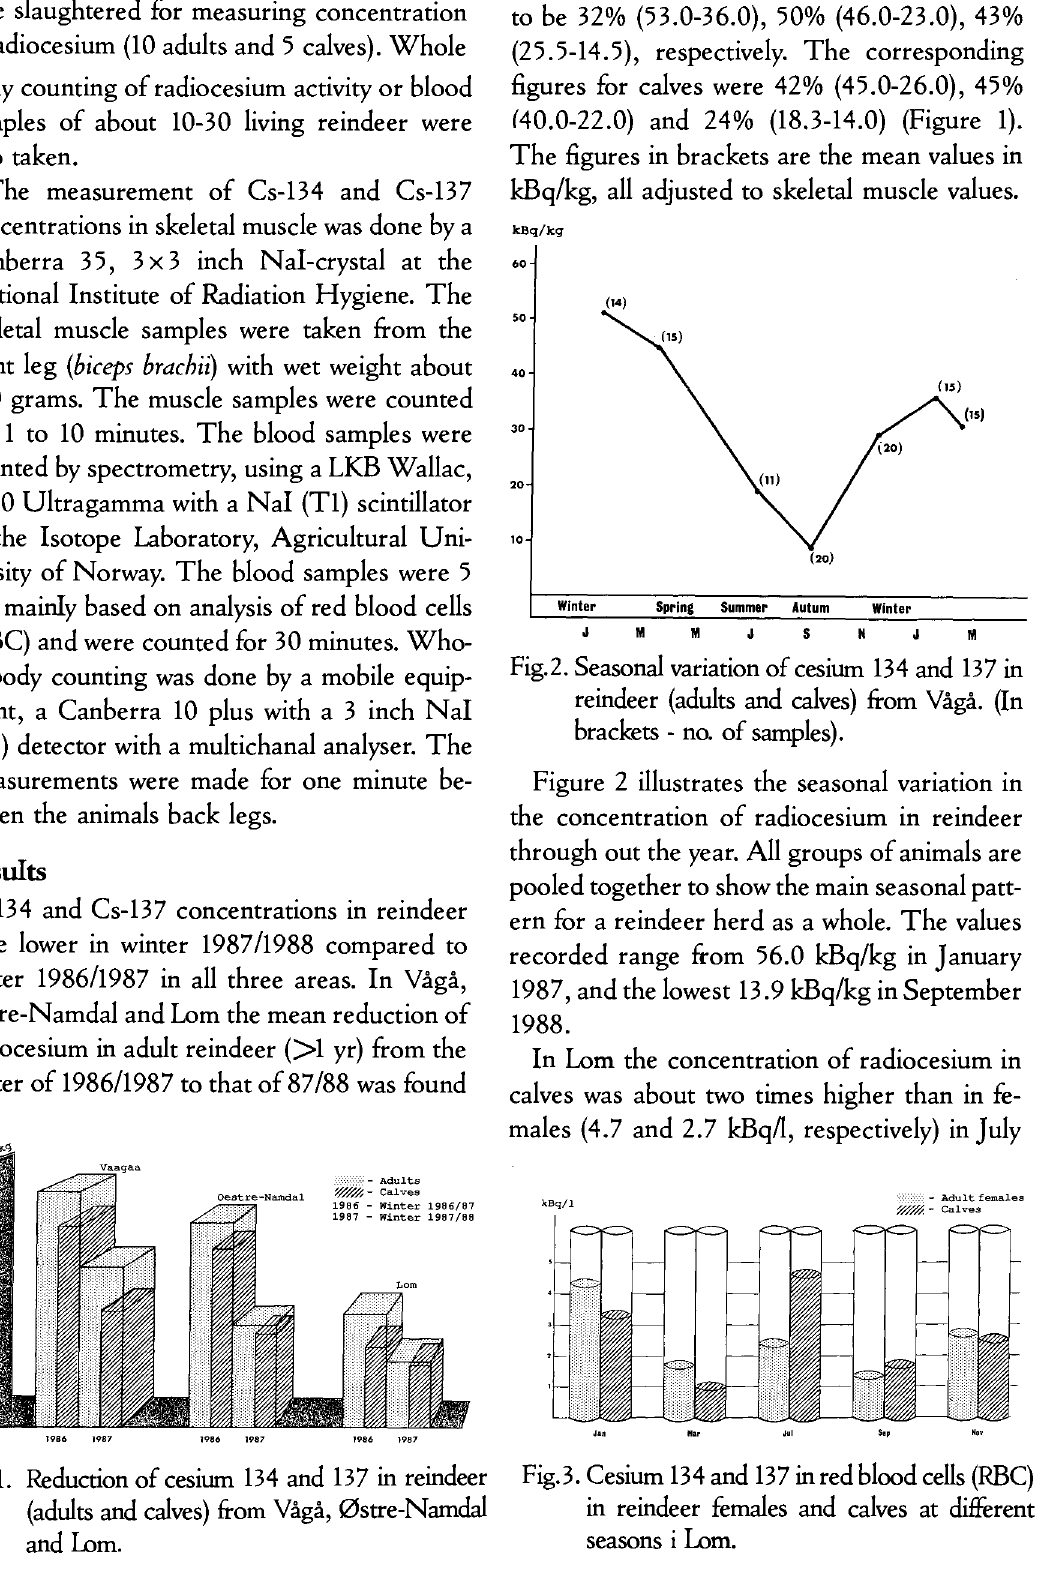
Fig. 1. Reduction of cesium 134 and 137 in reindeer (adults and calves) from Vågå, Østre-Namdal and Lom.